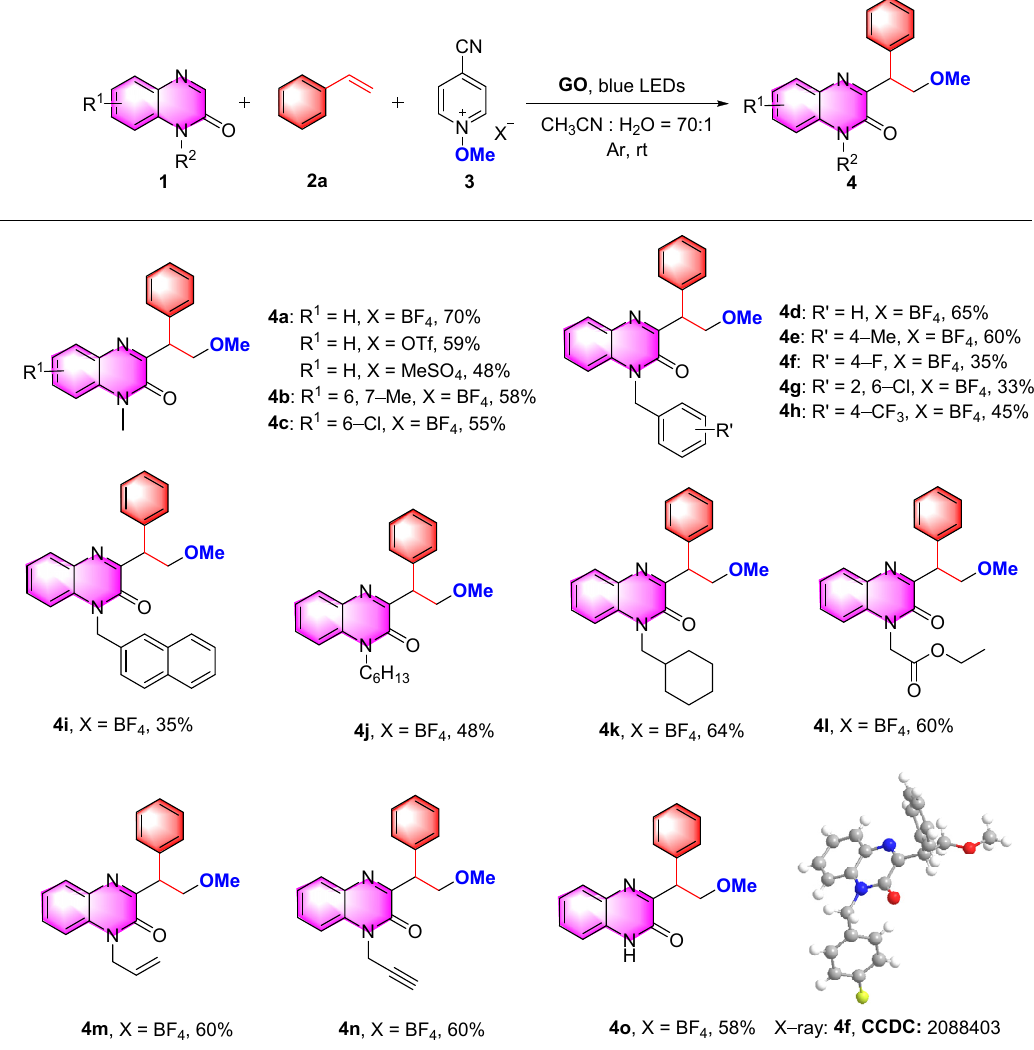
Scheme 2. Scope of the reaction with respect to various substituted quinoxalones a,b . a